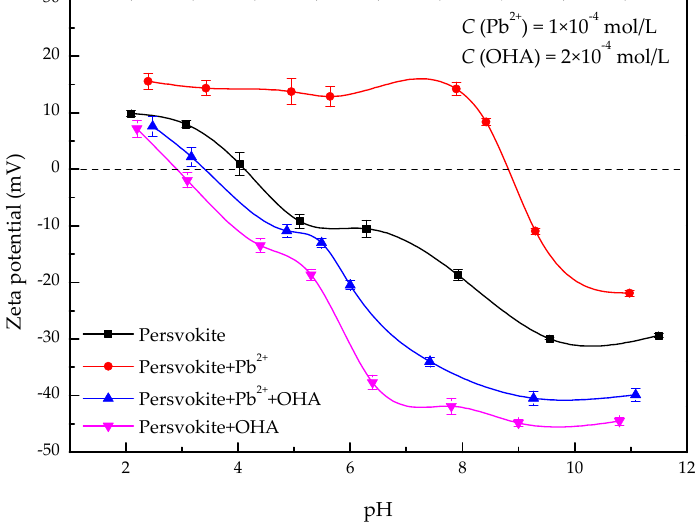
Figure 5. Zeta ‐ potentials of perovskite as a function of pH. Figure 5. Zeta-potentials of perovskite as a function of